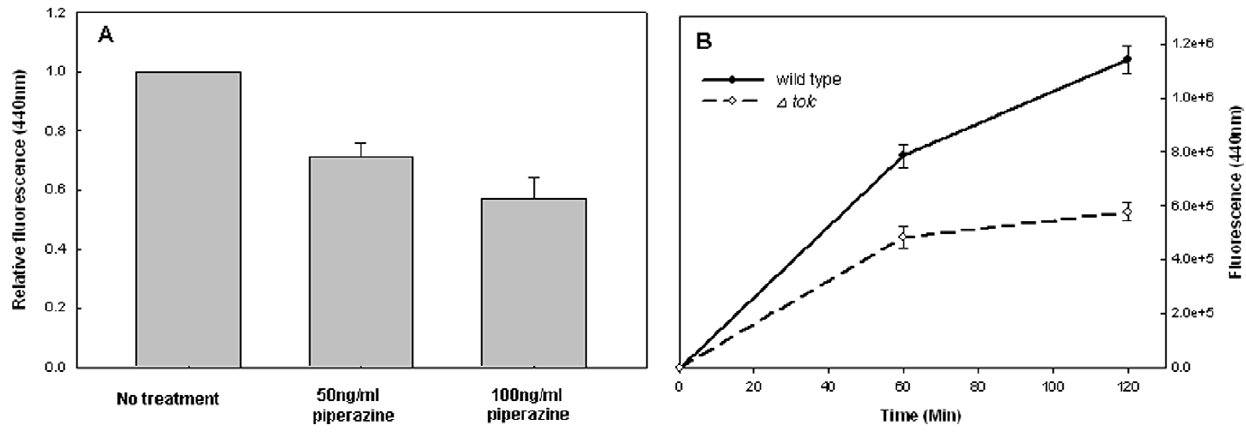
Figure 3. Effect of an efflux pumps inhibitor and tolC deletion mutant on AGEs secretion. Effect of A) 50 ng/ml and 100 ng/ml of piperazine or B) tolC deletion on the kinetics of AGEs secretion. The data represent three independent experiments.